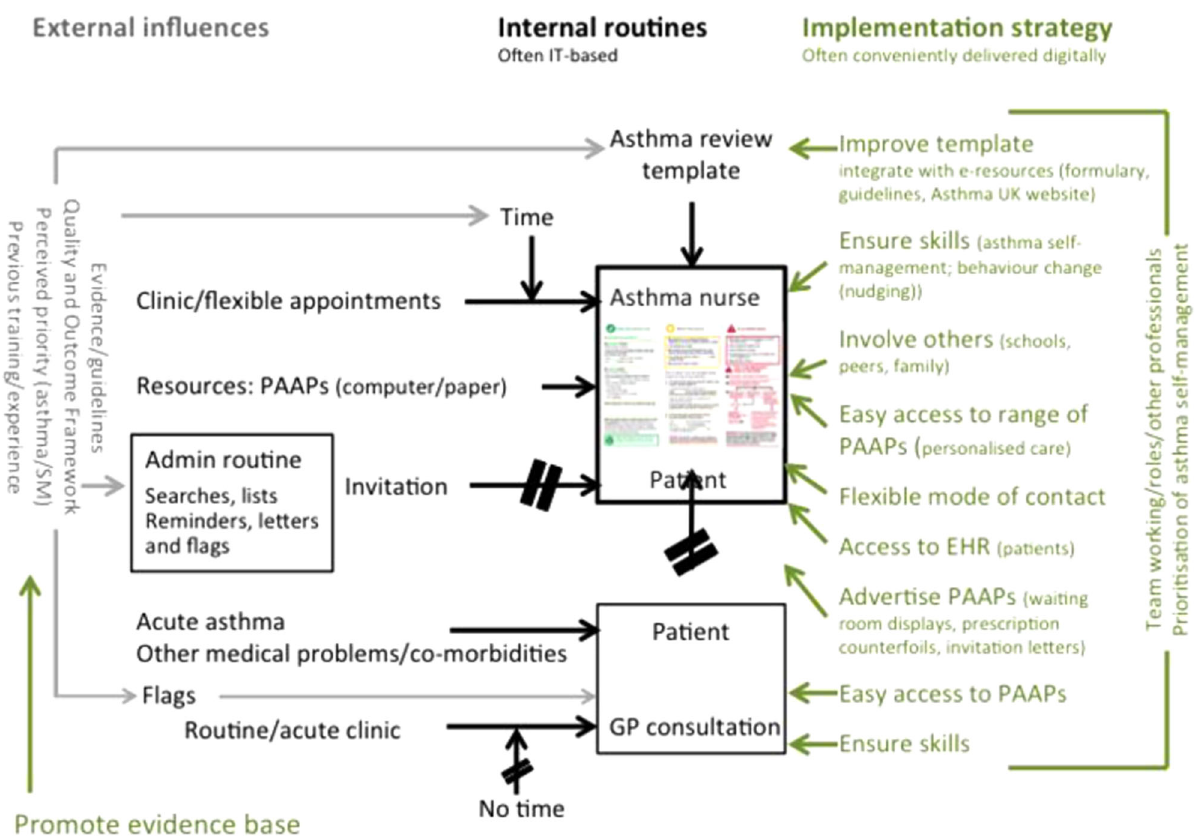
Fig. 1 Schema for a ‘ typical ’ routine for provision of self-management and personalised asthma action plans in general practices. The black boxes and lines in the schema illustrate a typical routine, described by doctors, nurses and practice staff, for providing asthma reviews and supported self-management. The grey text and lines illustrates the external in fl uences that in fl uence the priority attached to asthma care and supported self-management or which determine organisational arrangements. The green text and lines are suggestions made by the participants that they perceive might help overcome the challenges. PAAP Personalised Asthma Action